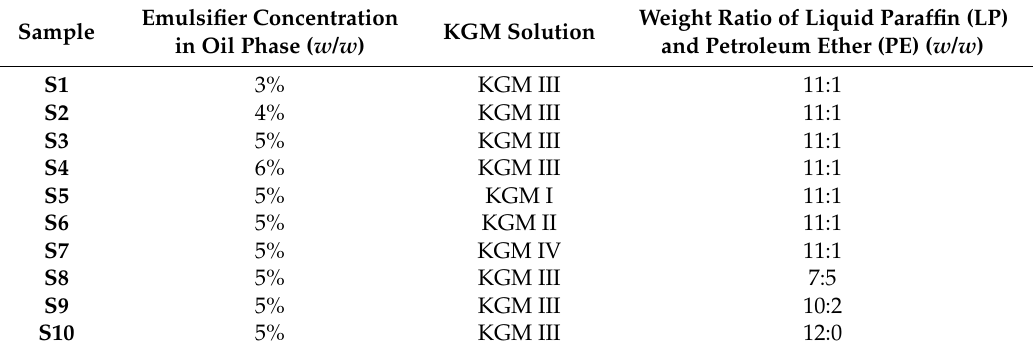
Table 2. Recipe for preparing KGM